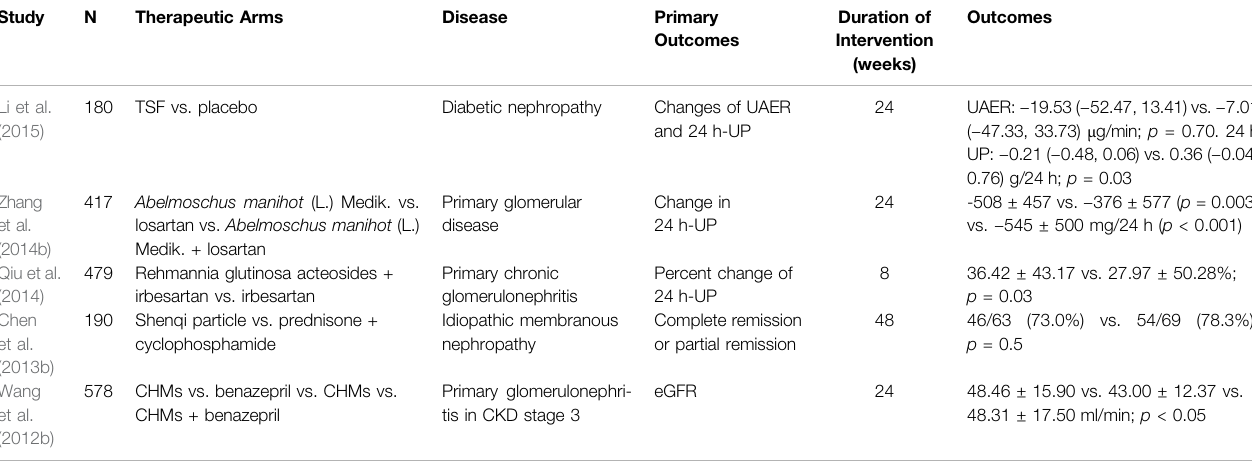
TABLE 2 | Large and well-designed RCTs with